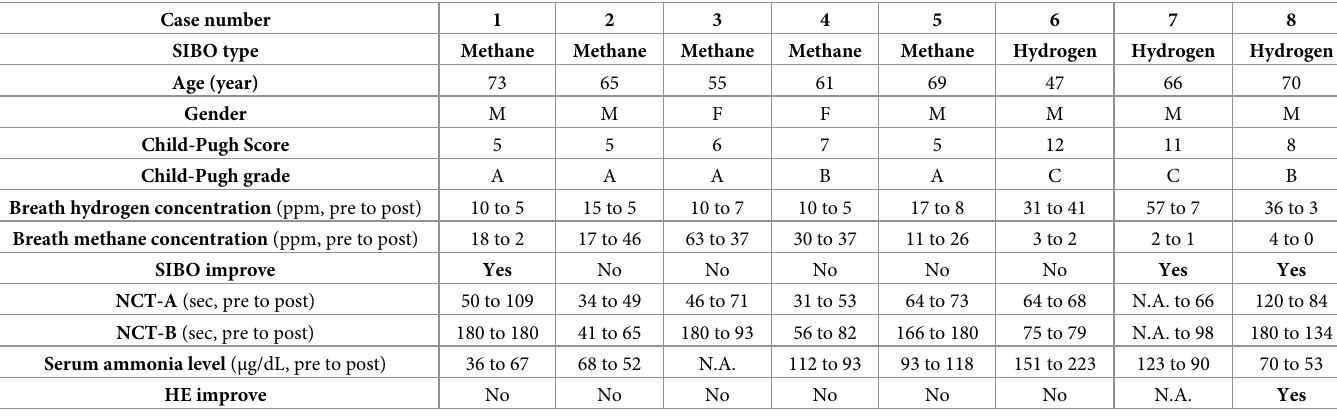
SIBO, small intestinal bacterial overgrowth; M, male; F, female; NCT, number connection test; HE, hepatic encephalopathy; N.A., not